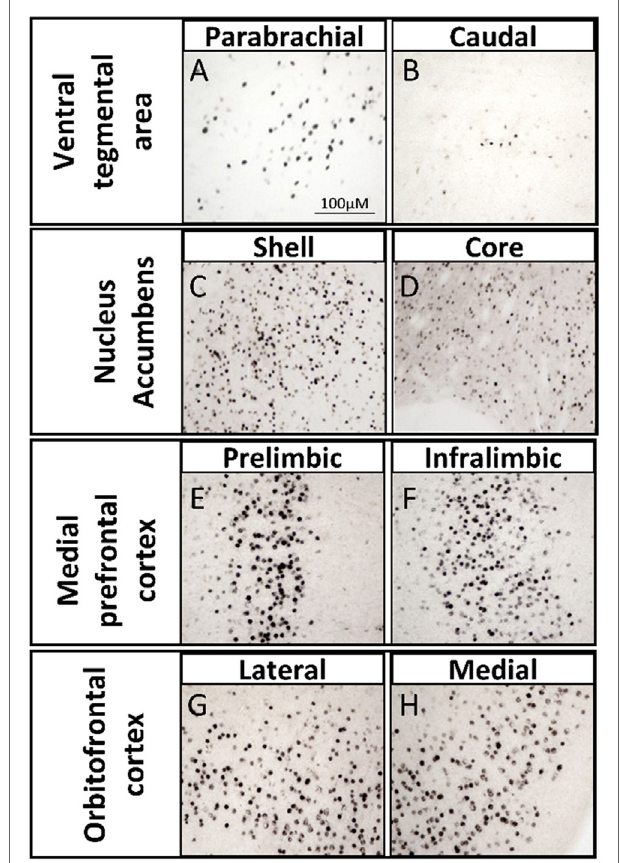
FiGURe 4 | Brightfield photomicrographs depicting androgen receptor immunoreactivity (AR­ir) with tyramide signal amplification in nodes of the mesocorticolimbic system of adult male rats. AR­ir in the (A) parabrachial pigmented nucleus of the ventral tegmental area (VTA), (B) caudal VTA, (C) shell of the nucleus accumbens (NAc), (D) core of the NAc, (e) prelimbic subregion of the medial prefrontal cortex (mPFC), (F) infralimbic subregion of the mPFC, (G) lateral subregion of the orbitofrontal cortex (OFC), and (H) medial subregion of the OFC. Adapted from Ref. (45).